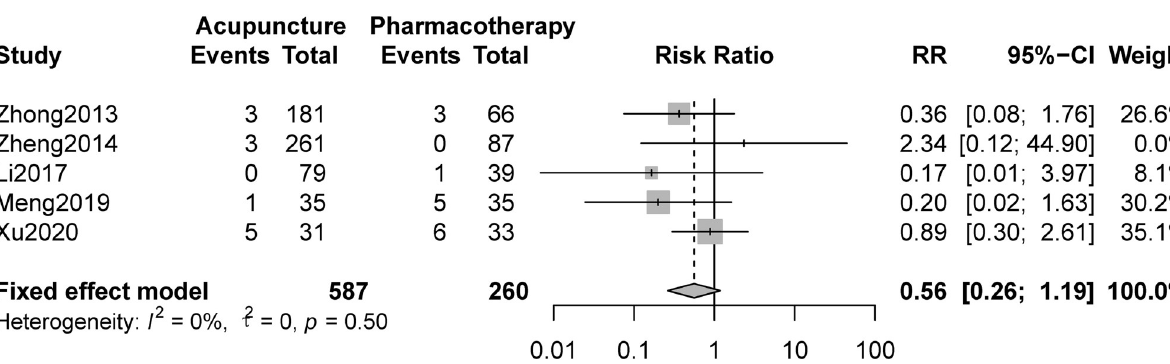
Fig 5. Forest plot of comparison: Acupuncture versus pharmacotherapy, outcome: Adverse events.